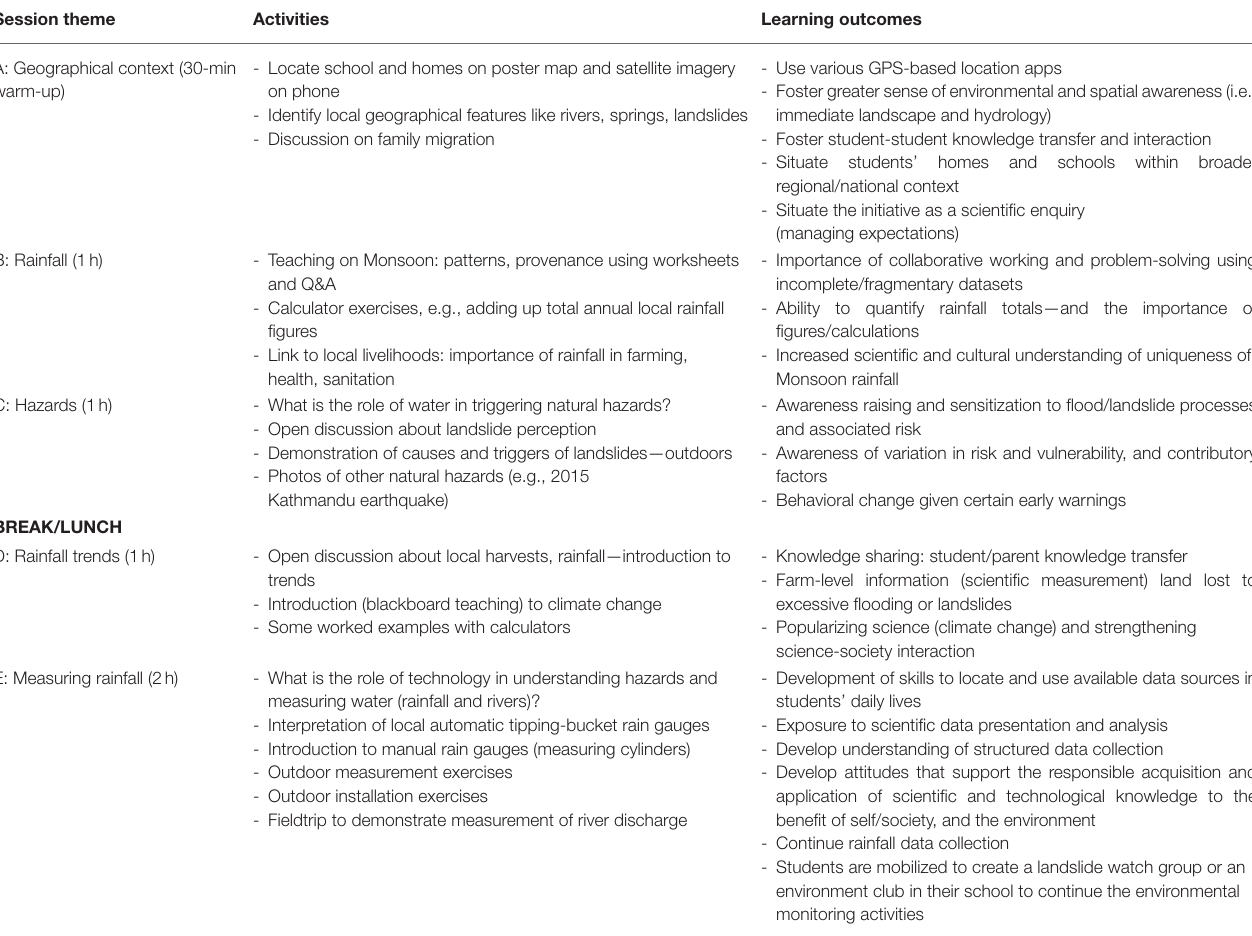
TABLE 2 | Summary of student